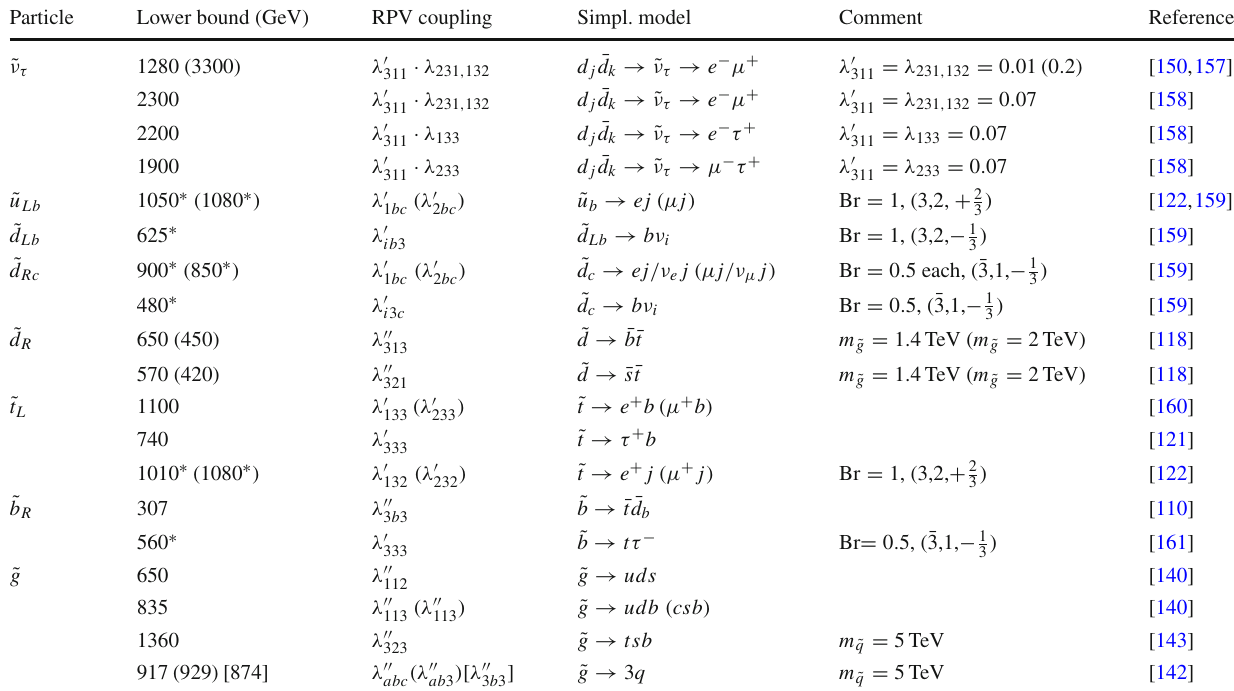
toquark scenarios. For the leptoquark searches, we have included the –CMSSM SU(3), SU(2), and U(1) EM quantum numbers in the comment P